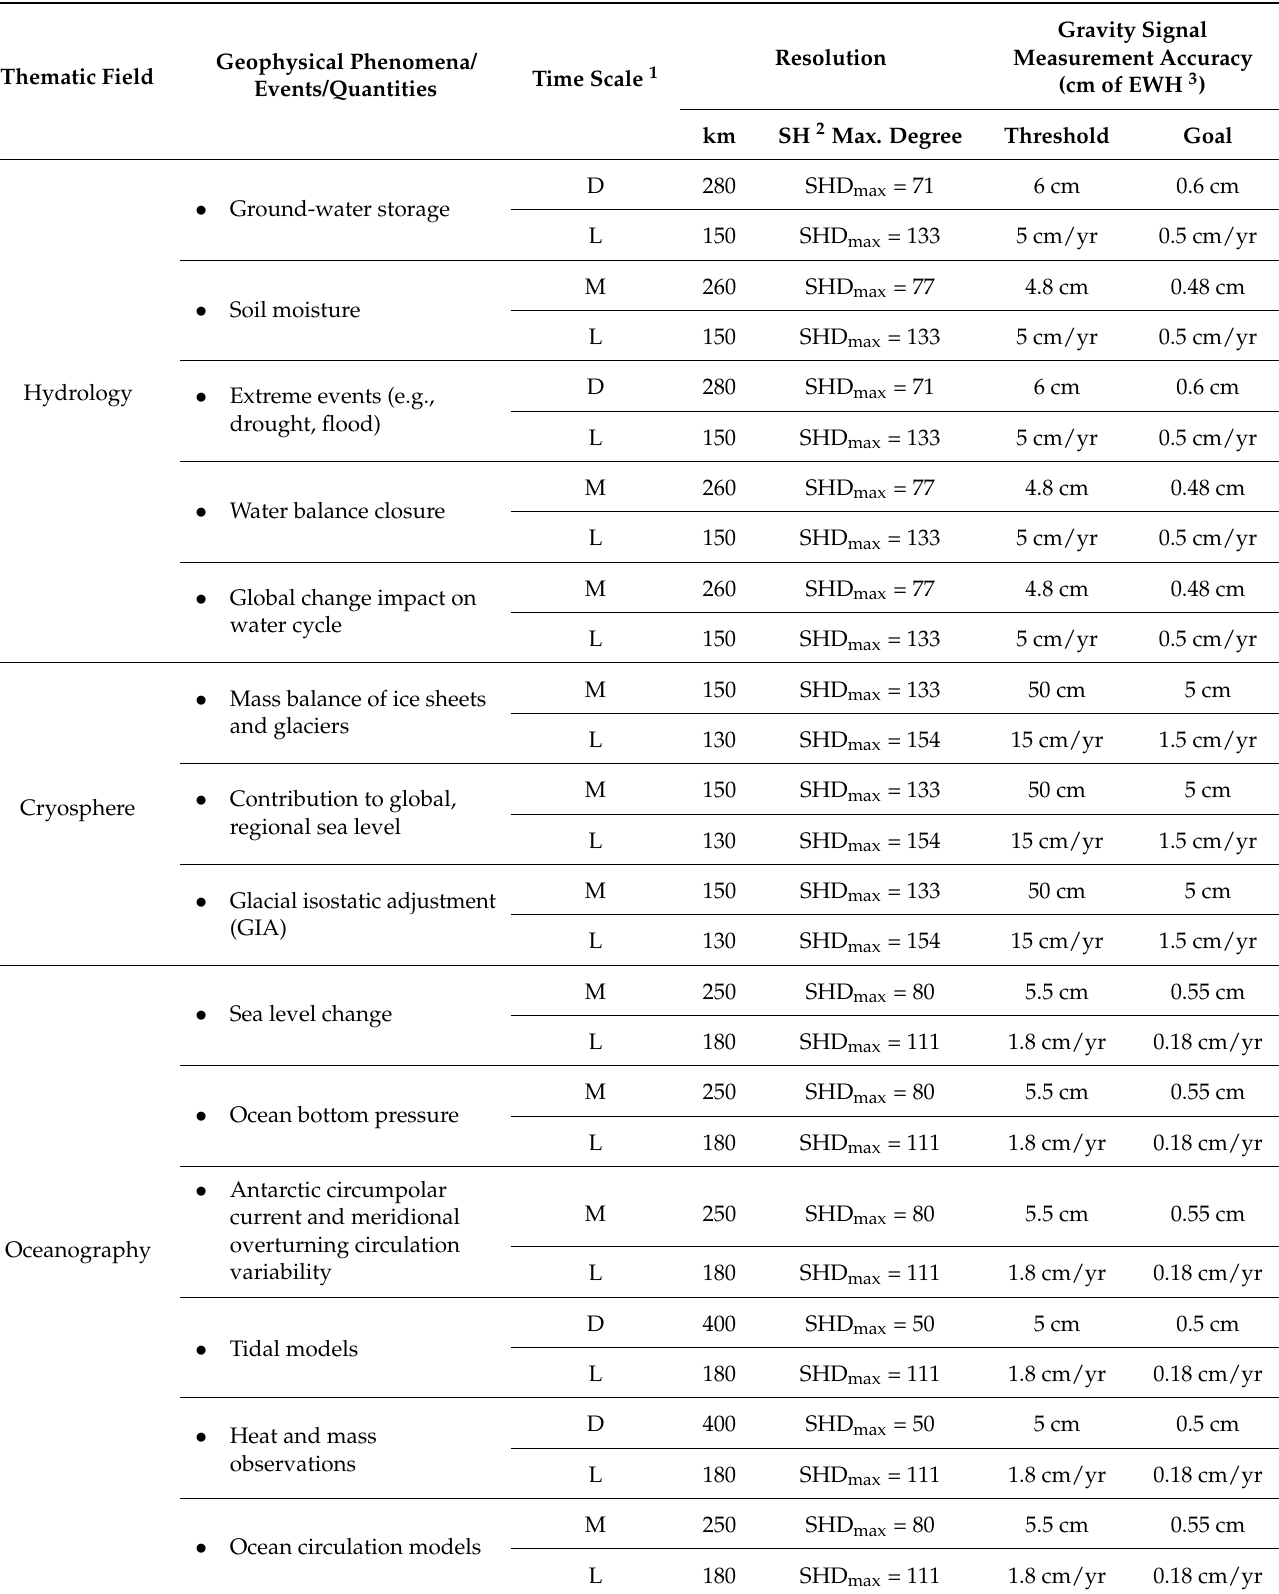
Table 1. Thematic fields and geophysical phenomena/events/quantities investigated by